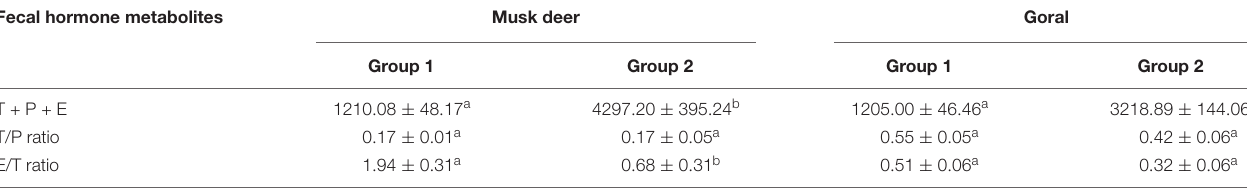
TABLE 2 | Fecal concentrations (ng/g) (Mean ± SE) of T + P + E, T/P ratio and E/T ratio in musk deer and goral.